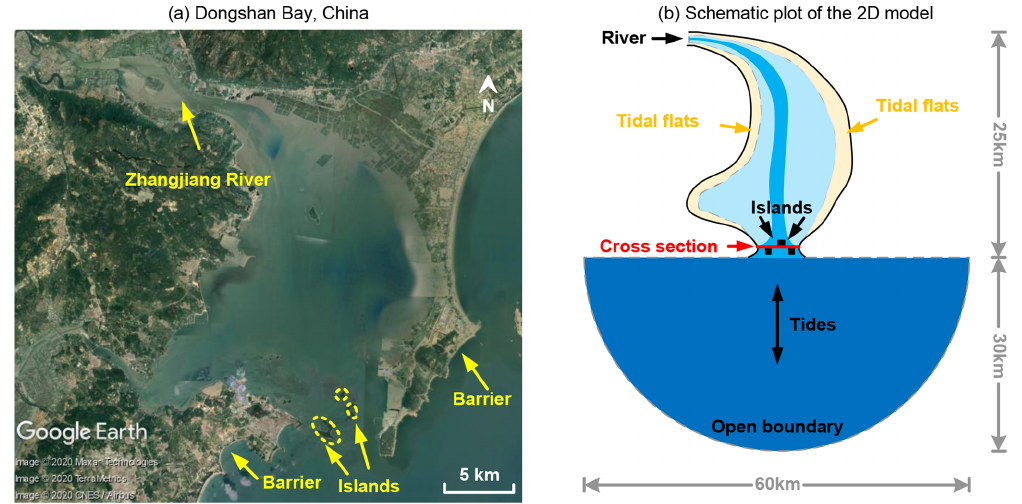
Figure 2. (a) The reference barrier basin with three mouth islands near the inlet, Dongshan Bay (23 ◦ 49 (cid:48) 48 (cid:48)(cid:48) N, 117 ◦ 31 (cid:48) 18 (cid:48)(cid:48) E; Im- age © Google Earth 2020, Maxar Technologies). (b) The schematized model domain used in this